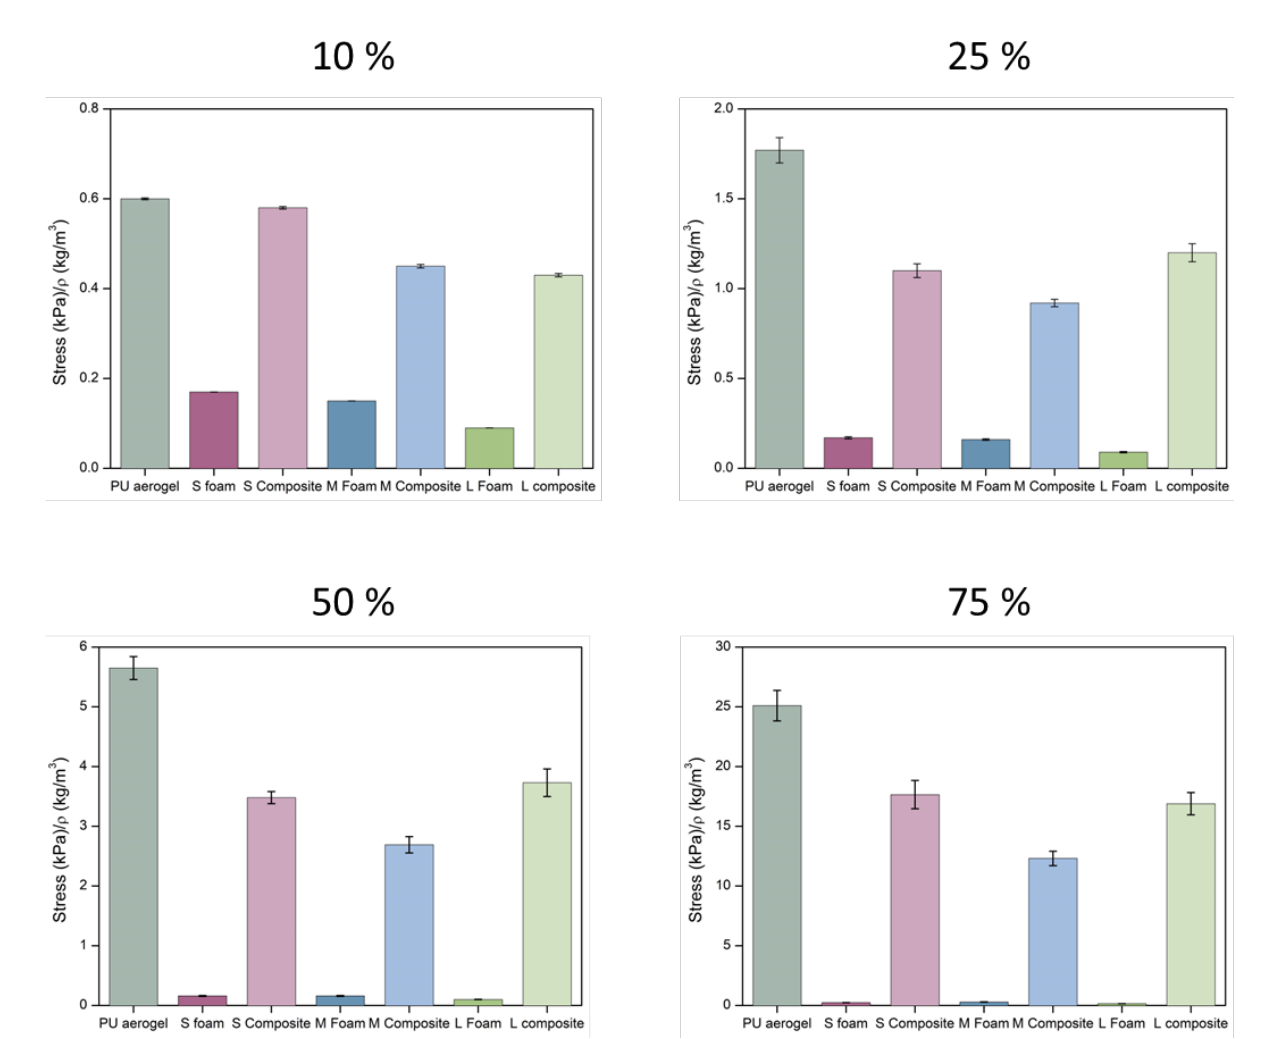
Figure 9. Normalized stress at different strains (10, 25, 50, and 75%) for the samples under